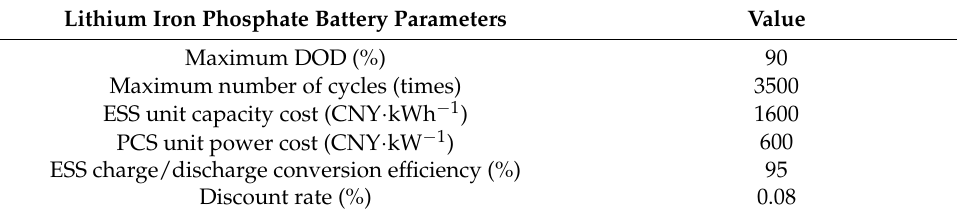
Table 1. Relevant parameters of energy storage